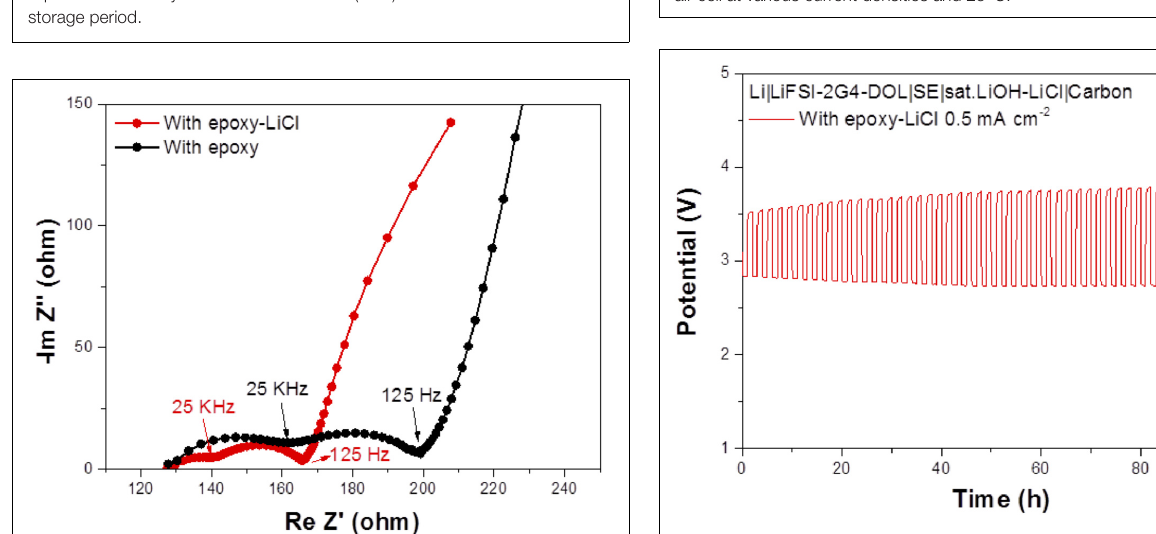
FIGURE 9 | Charge and discharge curves of the Li/(LiFSI-2G4)–50 vol% DOL/LAGTP or LAGTP-E-LiCl/saturated LiOH and LiCl aqueous solution/KB, air cell at various current densities and 25 ◦ C.